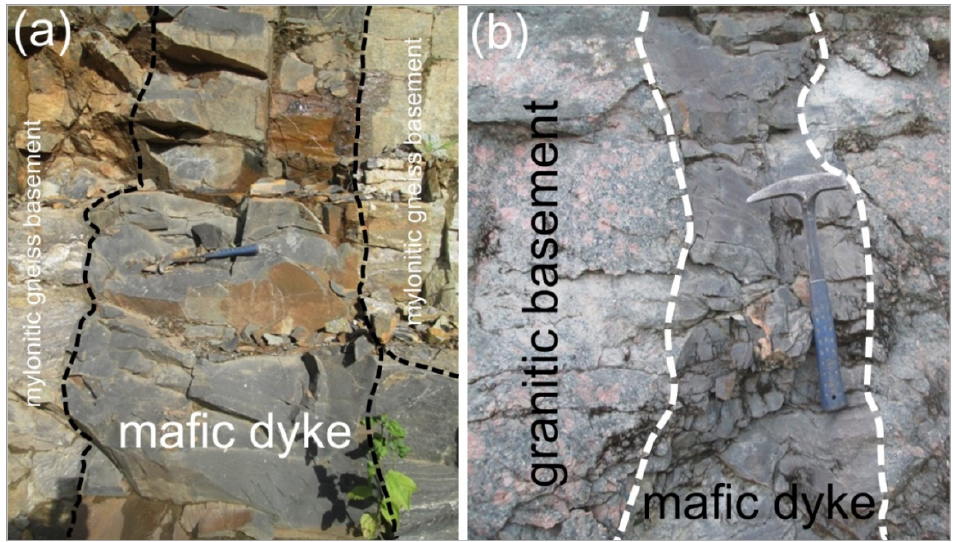
Figure 3. Field geology of Njimom area. ( a , b ) Dykes cross-cutting the Precambrian basement (mylonitic gneiss) in ( a ) and (granite) in ( b ).